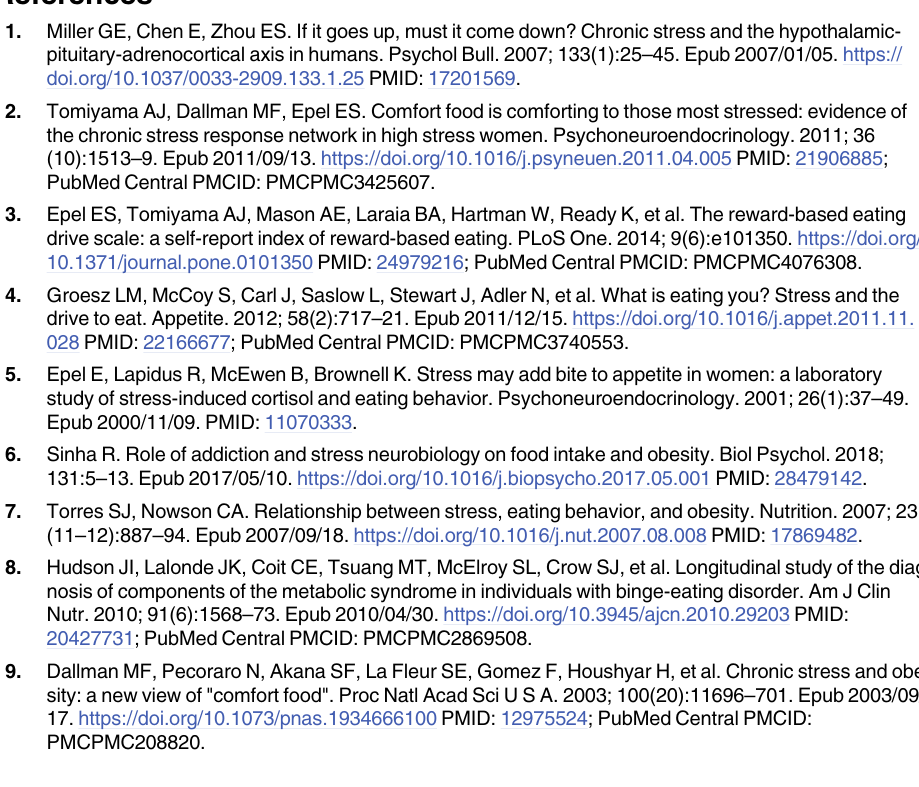
S1 Table. Metabolic syndrome criteria: International Diabetes Federation